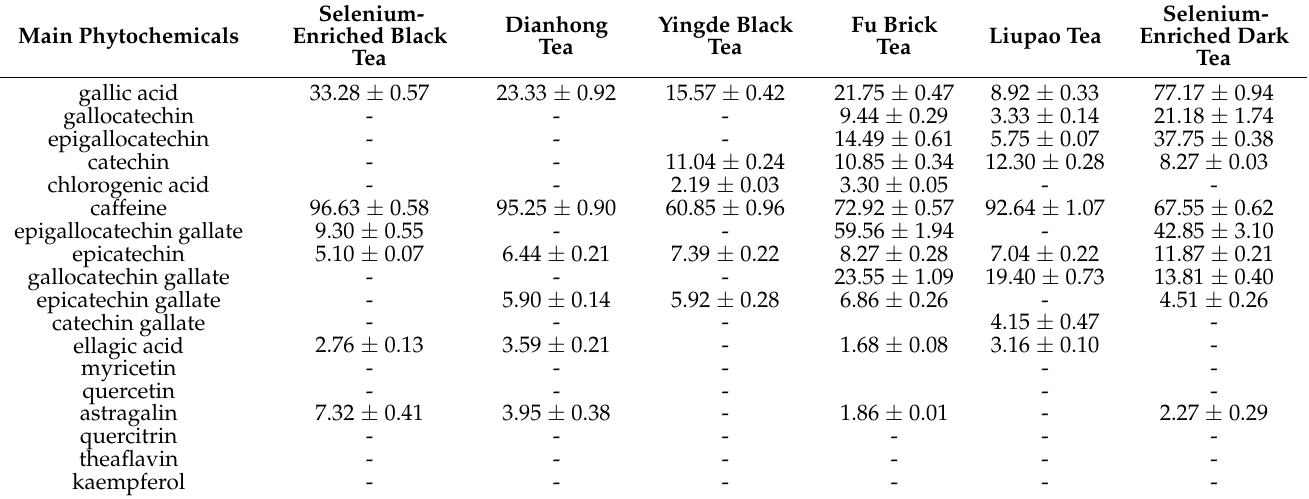
Abbreviations: -, mean not detected. The results are expressed as mean ± standard deviation. Thirteen ingredients have been determined to be present in different black and dark tea extracts, including eight catechins and five other active substances (gallic acid, chloro- genic acid, caffeine, ellagic acid and astragalus). The 8 catechins are EGCG, gallocatechin gallate (GCG), epicatechin gallate (ECG), catechin gallate (CG), gallocatechin (GC), epi- gallocatechin (EGC), epicatechin (EC), and catechin. The results indicated that the dark teas contained more abundant catechins compared with the black teas, and that all eight catechins were detected in dark tea. However, the content of catechin in black and dark tea was low compared with green tea [27], because black tea and dark tea are highly fer- mented [63]. In addition, we found that caffeine was abundant in all black and dark teas, with concentrations ranging from 60.85 ± 0.96 to 96.63 ± 0.58 mg/g. It has been reported that caffeine consumption could promote energy metabolism and is closely associated with improvement in the obesity and NAFLD [64]. Moreover, gallic acid was determined in different black and dark teas ranging from 8.92 ± 0.33 to 77.17 ± 0.94 mg/g, which was associated with the degradation of catechins during the fermentation process of black and dark